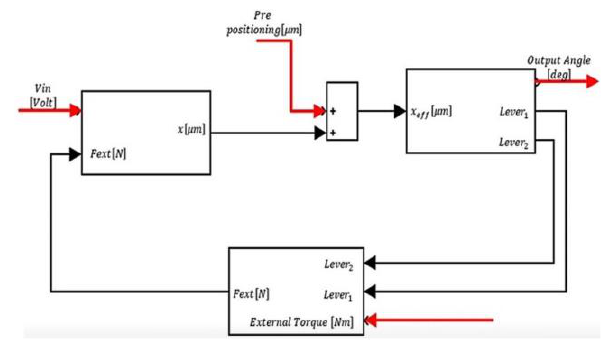
Figure 9. The combined system model. [24].